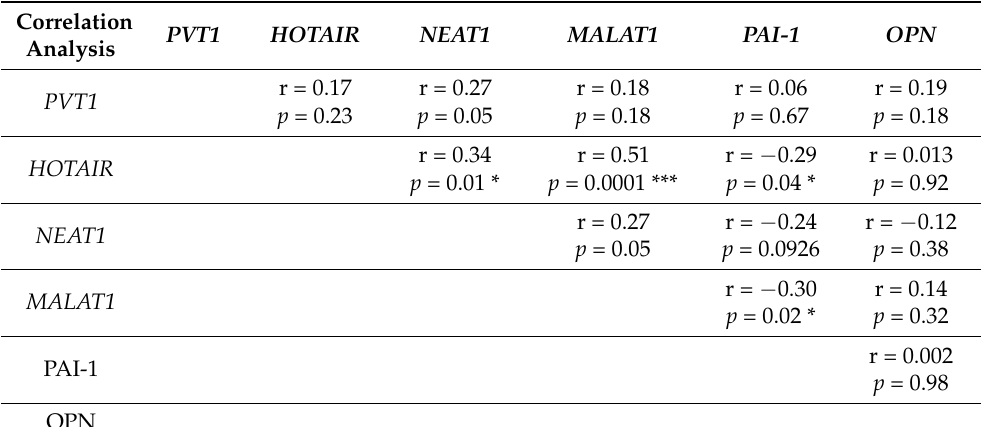
Table 6. Correlation analysis between the serum levels of PVT1, HOTAIR, NEAT1, MALAT1, PAI-1, and OPN in the breast cancer